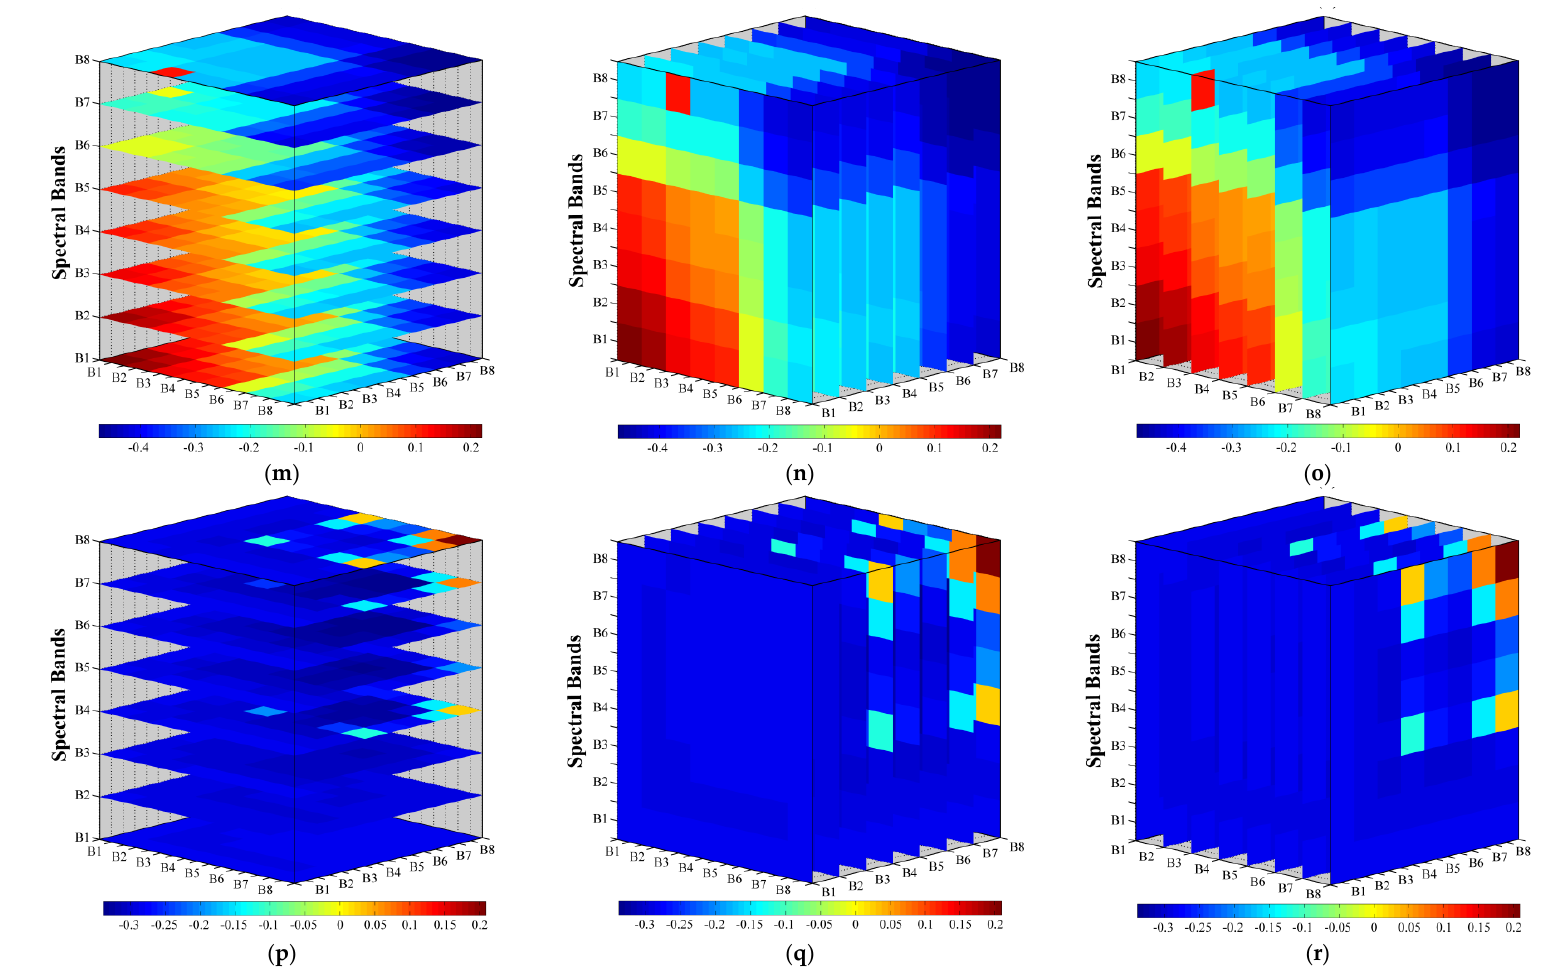
Figure 11. The correlation analysis between EC and optimized spectral indices based on different mathematical algorithms. ( a ) - ( r ) represent the horizontal slice map and vertical slice map, and the slice maps indicated the correlation between the EC and the spectral index (SI 2 ), respectively.